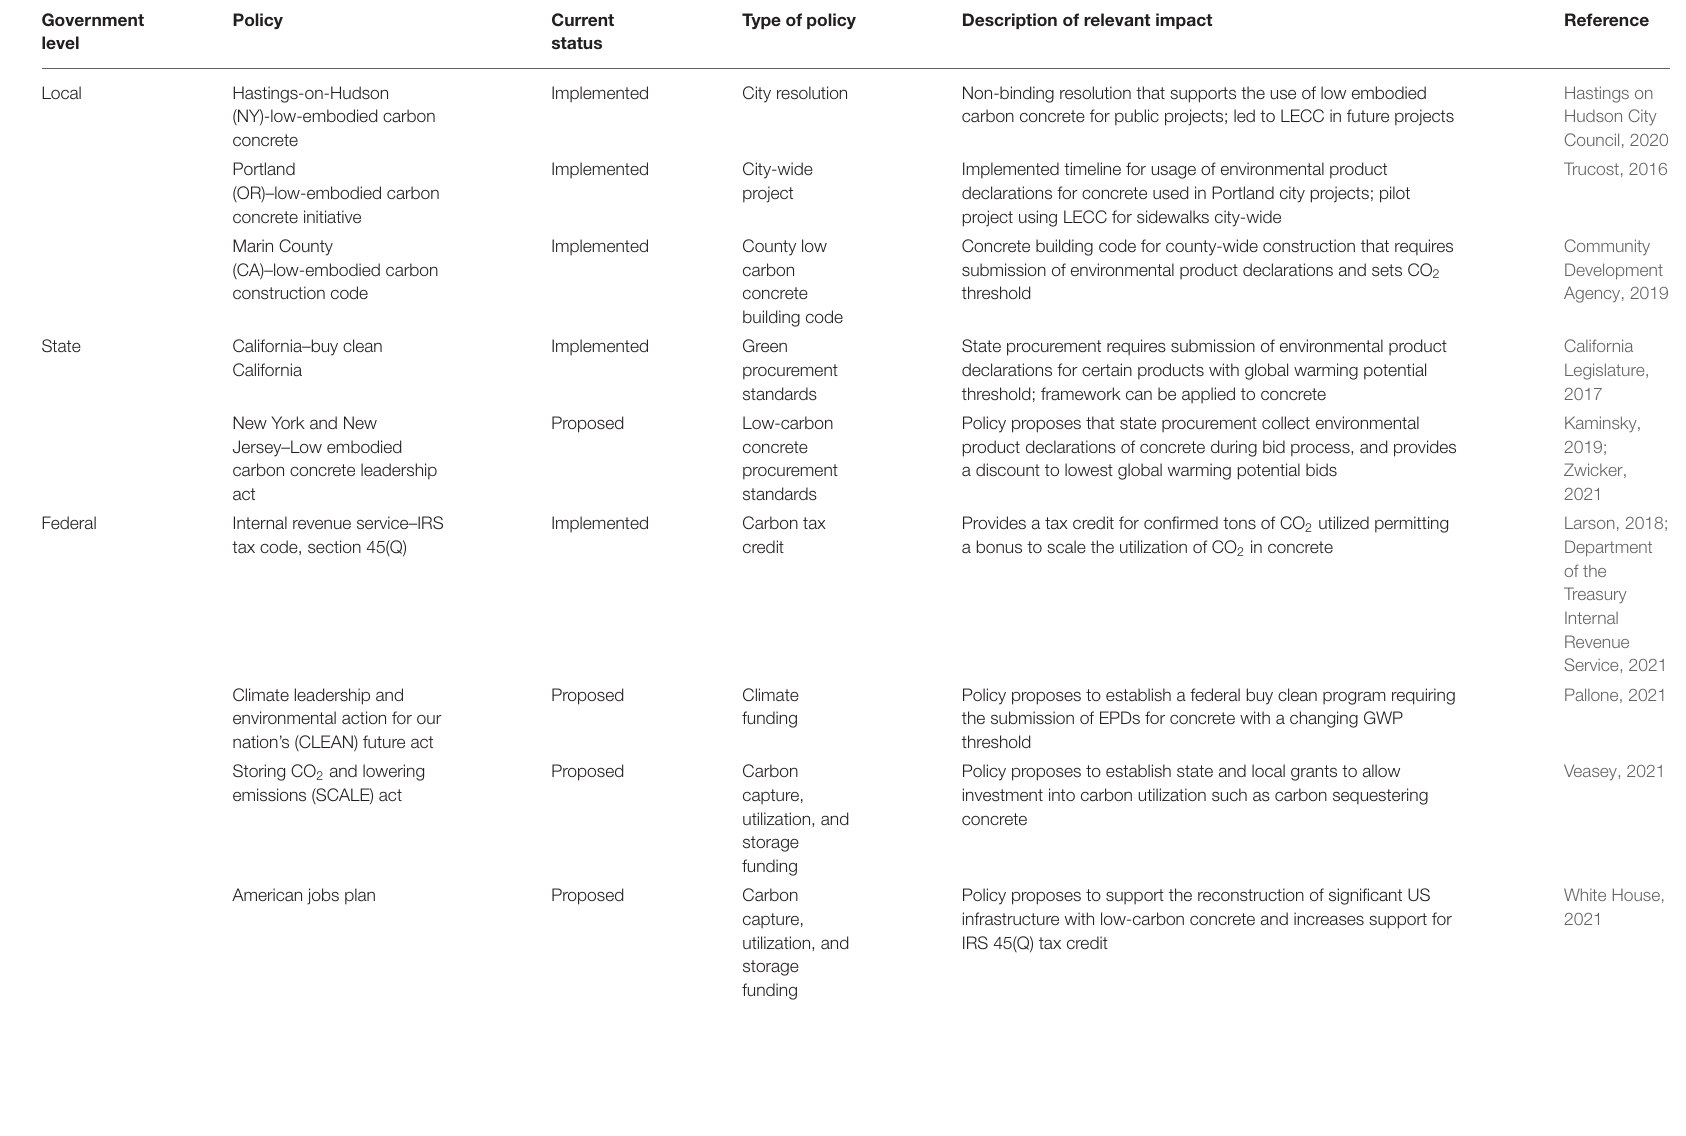
TABLE 1 | Existing and proposed United States policies that promote low carbon construction. Government